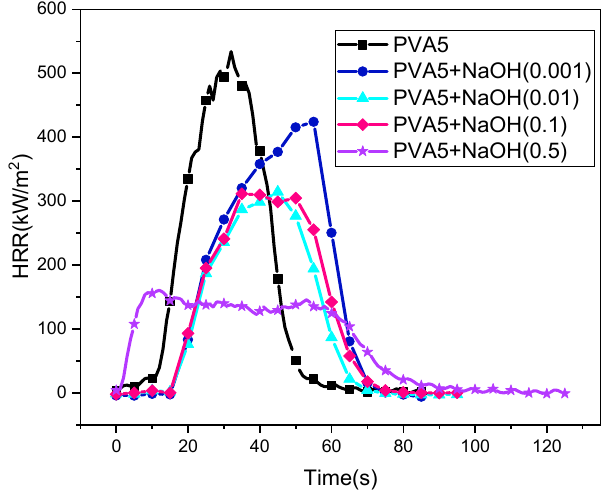
Figure 2. TGA and DTG (differential gravimetry) curves of PVA and PVA/NaOH aerogels at a heating rate of 10 °C/min under nitrogen.